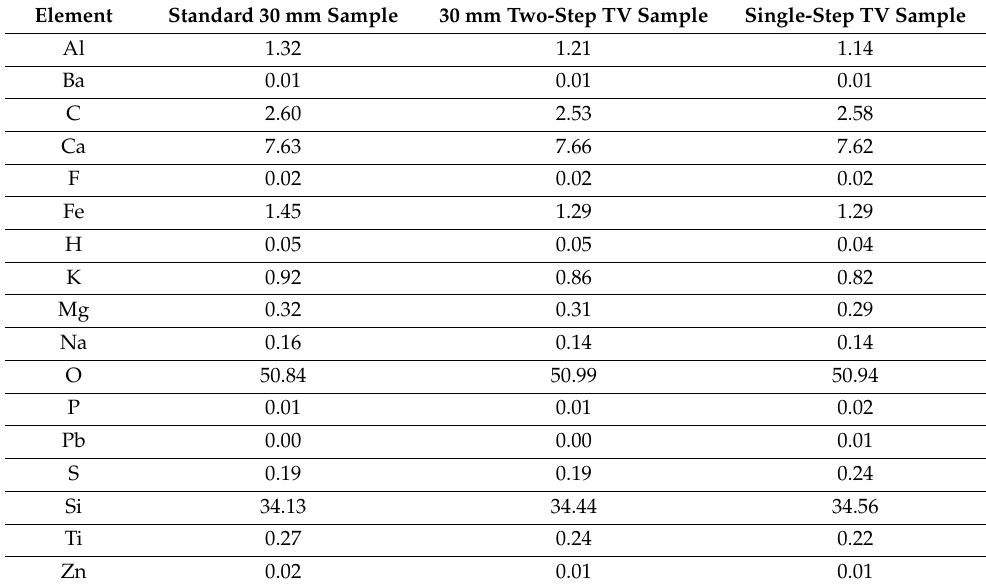
Table 2 lists the MLA calculated assay results for each of the three sample prep method. The elemental assay values for the both the two-step and single-step trans-vertical mould align well with the standard mounting method. Table 2. Comparison of MLA calculated assay for sample 2 across the sample prep